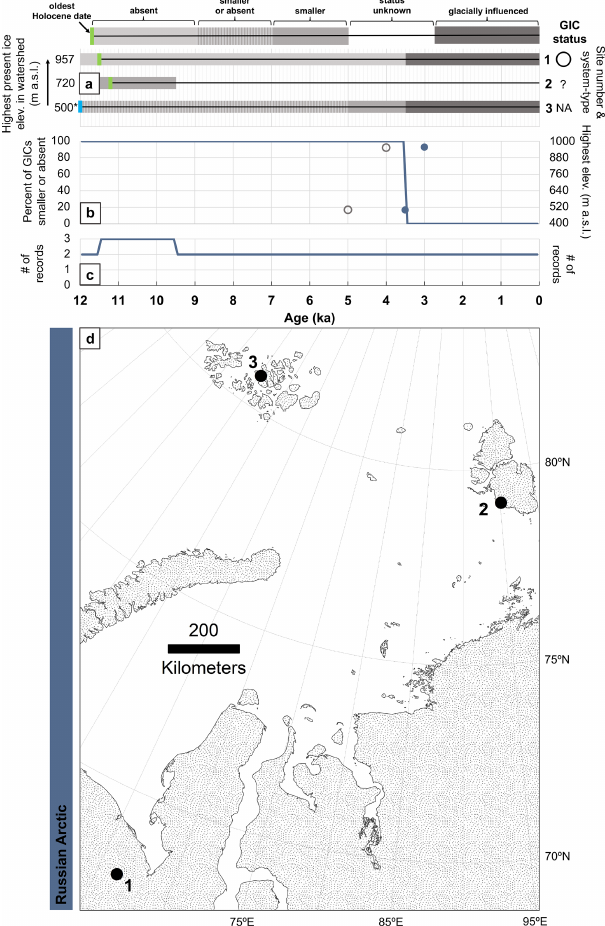
Figure 9. Holocene lake-based GIC records from the Russian Arc- tic. Panel descriptions, symbols, and colors are the same as in Fig. 3. Sites are as follows: 1. Svendsen et al. (2019), Haflidason et al. (2019) (Lake Bolshoye Shchuchye, unnamed glaciers); 2. An- dreev et al. (2008) (Changeable Lake, Vavilov Ice Cap); 3. Lubin- ski et al. (1999) (non-lake record, review of 16 glacier margins in Franz Josef Land). We note that the oldest reported age from Lake Bolshoye Shchuchye (i.e., Svendsen et al., 2019; Haflidason et al., 2019) is pre-Holocene. We report the oldest Holocene age. At present, there are a few very tiny cirque glaciers around the lake; however, the theoretical snow line in the Polar Urals is already well above the highest mountain peaks (Svendsen et al., 2019). In addi- tion, the timing of glacier regrowth is reported sometime between ∼ 4 and 3ka. We use an average for the timing of regrowth (i.e., 3.5ka) in panel (a) , but we use 4ka as the earliest regrowth and 3ka as the timing of sustained regrowth in panel (b) . ∗ We report the av- erage present summit elevation of ice caps in Franz Josef Land for the non-lake record summary in panel (a) . We note that the glacier– lake system type for record 2 is